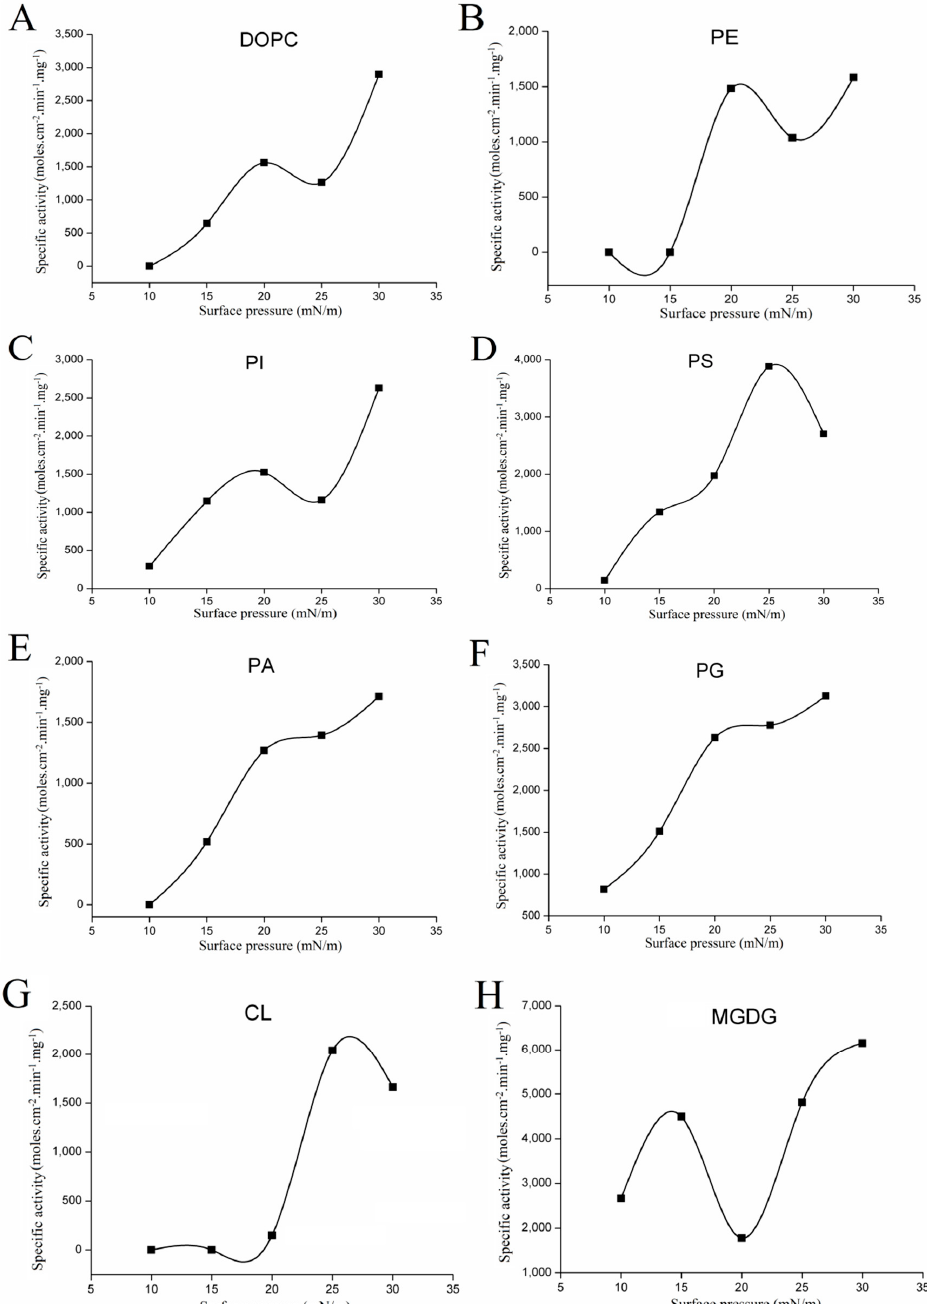
Figure 4. Variations with surface pressure on catalytic activity of rGZEL using different phospholipids. (PE), ( C ) L - α -phosphatidylinositol (PI), ( D ) 1,2-diacyl- sn -glycero-3-phospho- L -serine (PS), ( E ) 3- sn -phosphatidic acid sodium salt (PA), ( F ) 1,2-dioleoyl- sn -glycero-3-phospho-rac-(1-glycerol) sodium salt (PG), ( G ) cardiolipin (CL), ( H ) 1,2-distearoyimonoglactosylglyceride (MGDG). Assays were carried out at room temperature in a “zero-order” trough (volume, 2.5 mL; surface area, 12.56 cm 2 ). Buffer: 50 mM PB (pH 6.0). Activities were expressed as the number of moles of substrate hydrolyzed per unit time and unit reaction compartment area per milligram of enzyme in the “zero-order” trough (moles cm − 2 min − 1 mg − 1